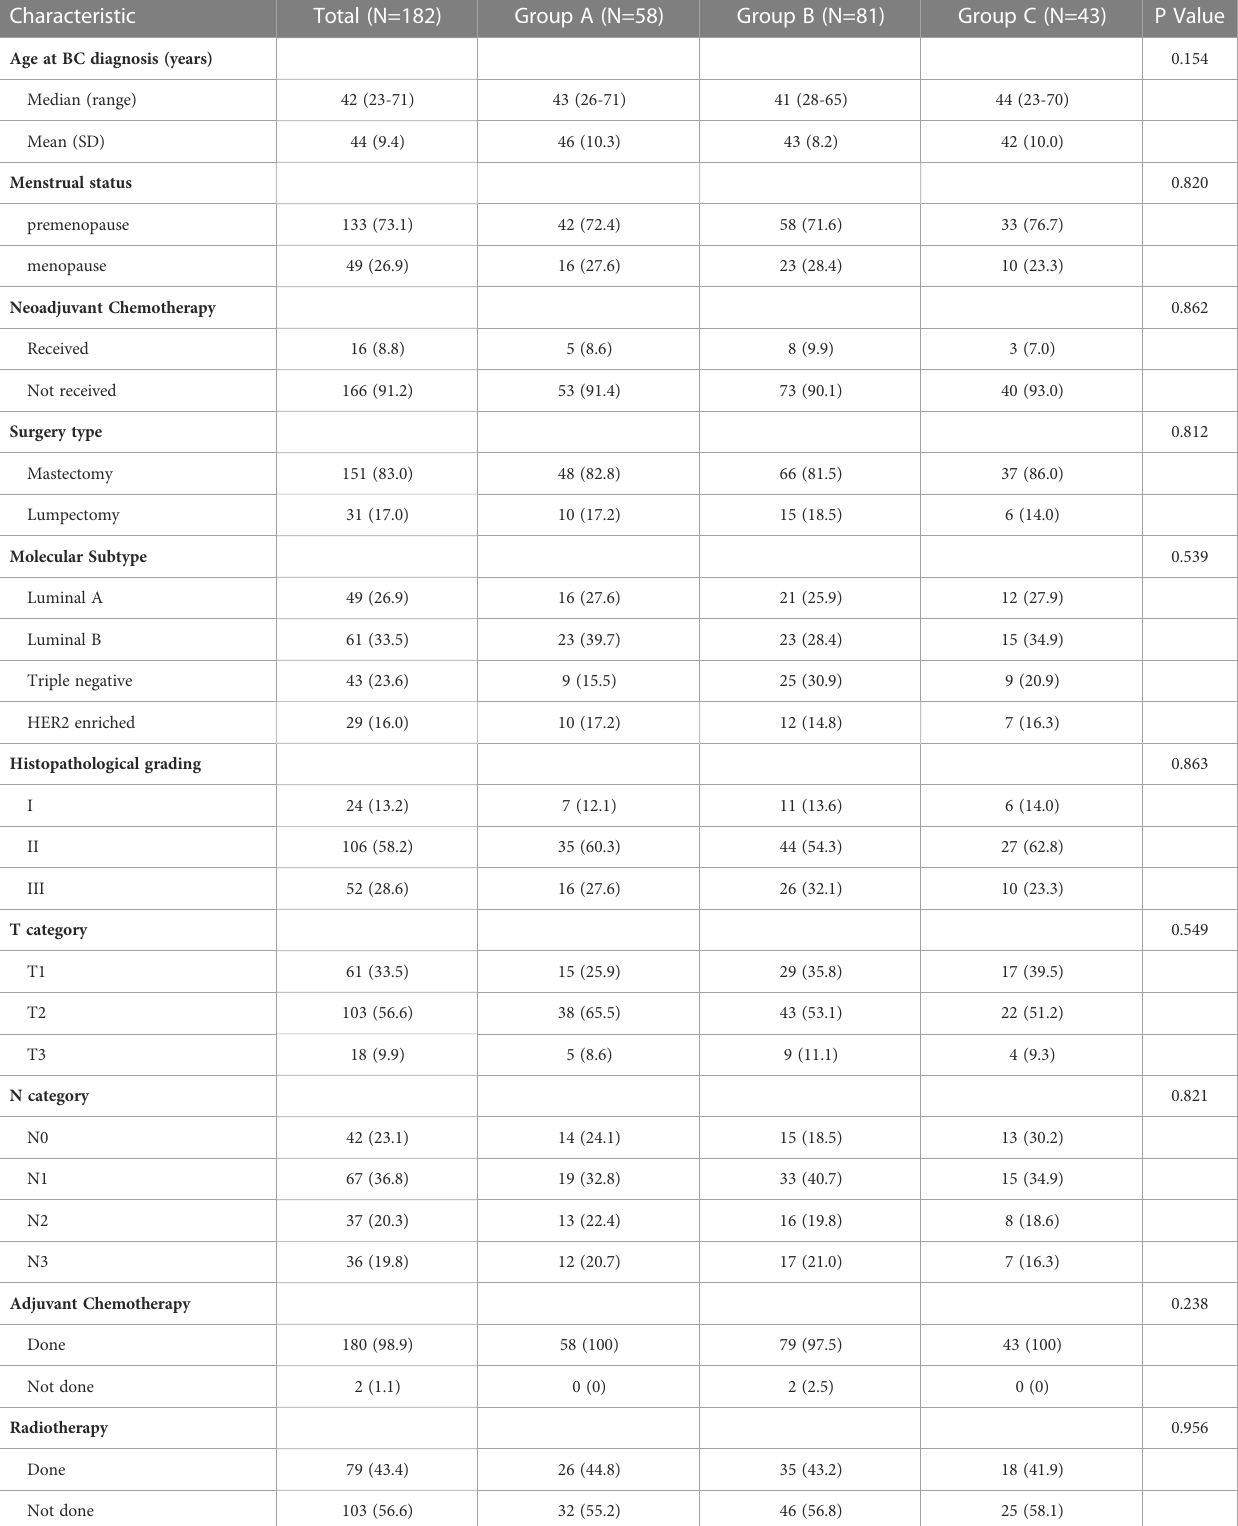
TABLE 1 Baseline characteristics of the entire